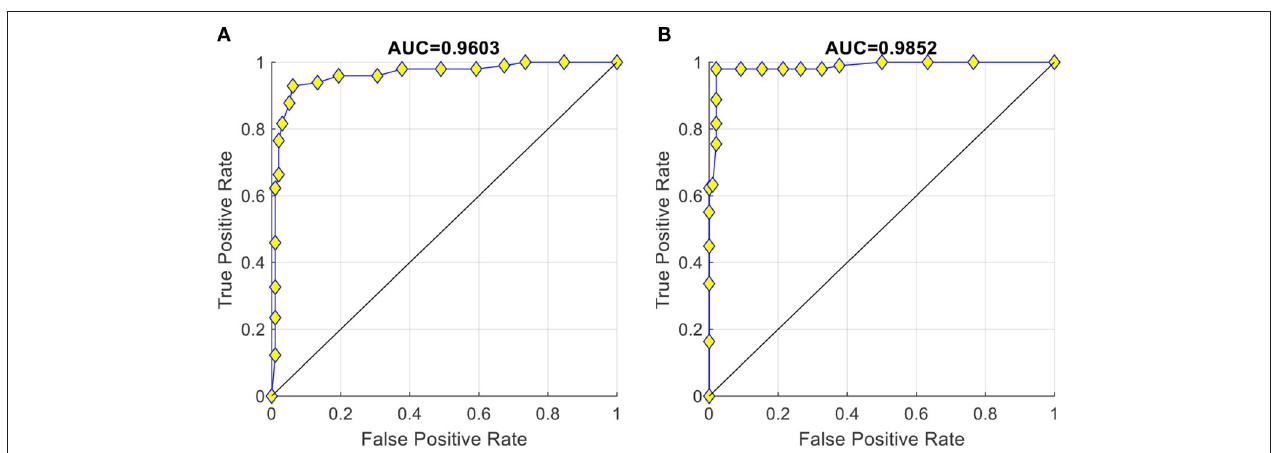
FIGURE 14 | ROC curves of the effectiveness of 18-way DA (w/ means with wo/ means without). (A) wo/MDA, (B) w/MDA.